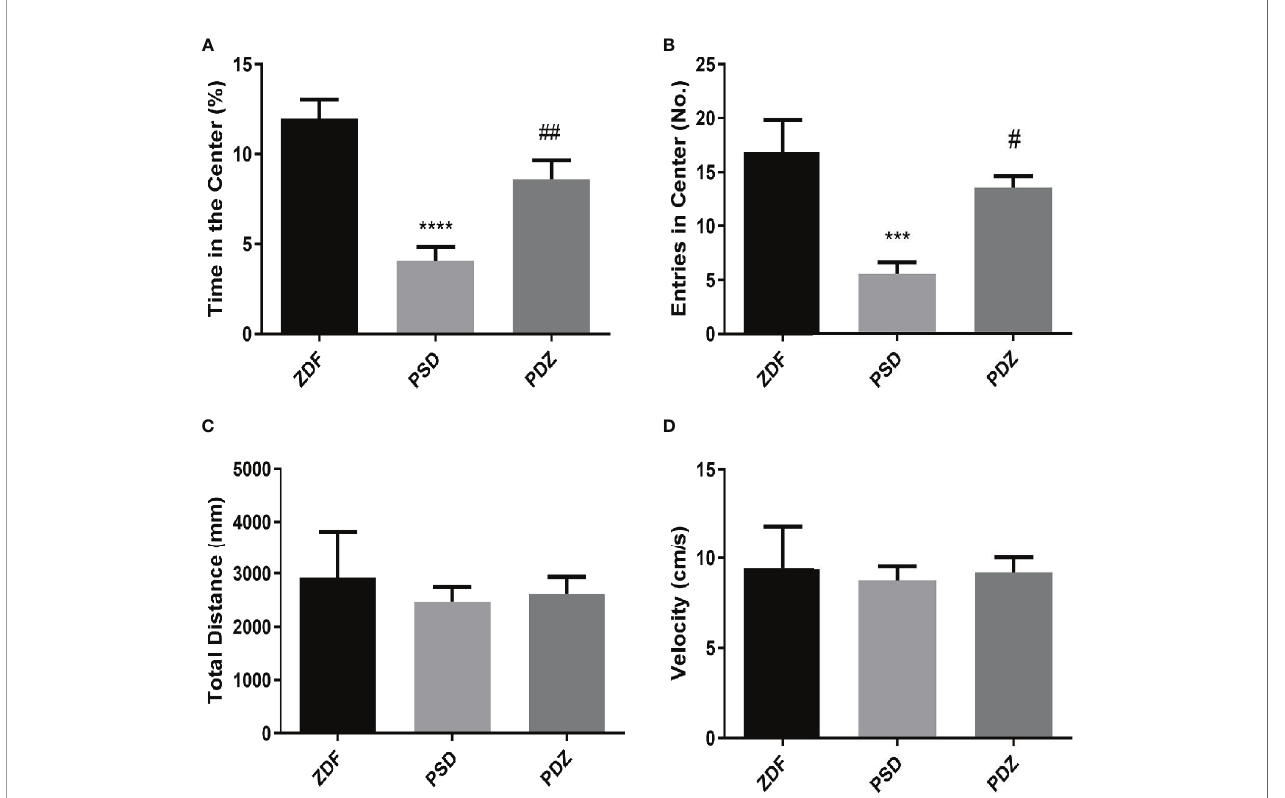
FIGURE 2 | Effect ZBPYR on activities in the open- fi eld test. Performance of ZDF rats in each group was measured, including time in the center (%) (A) , entries in the center (B) , total distance (C) and velocity (D) . Bars represent the mean ± SEM of 6 rats per group. *** P < 0.001, **** P < 0.0001, PSD group vs. ZDF group;